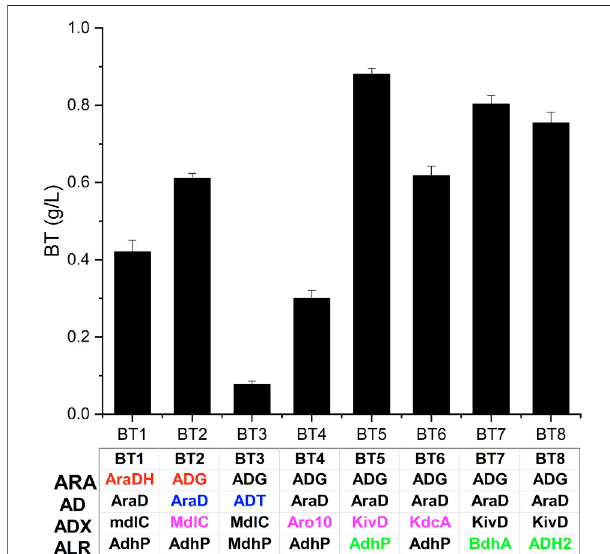
FIGURE3| ScreeningenzymesforimprovedproductionofBT.BT1and BT2 are used to evaluate the effect of ARA and enzyme names are shown in red;BT2andBT3areusedtoevaluatetheeffectofADandenzymenamesare showninblue;BT2,BT4,BT5,andBT6areusedtoevaluatetheeffectof ADX and enzyme names are shown in magenta; BT5, BT7, and BT8 are used to evaluate the effect of ALR and enzyme names are shown in green. Four enzymes expressed in each strain are listed in the table. Error bars represent SD ( n =